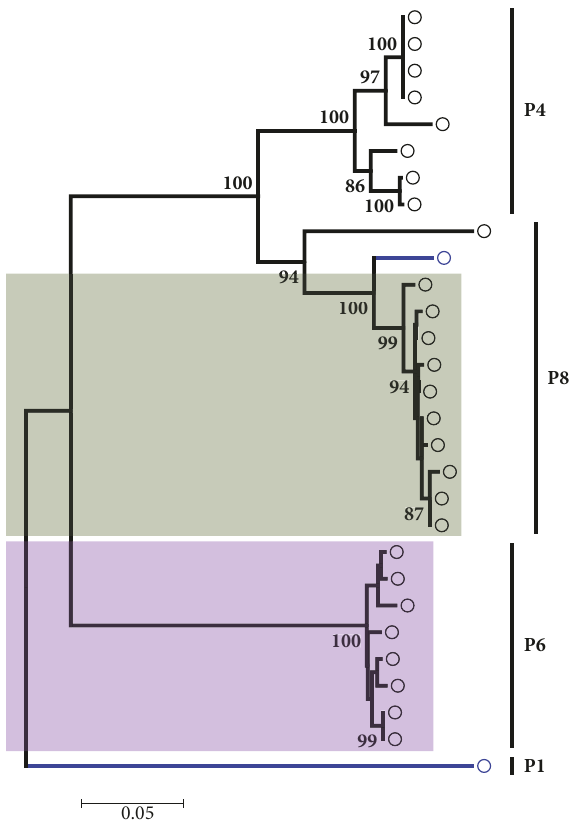
Figure 3: Phylogenetic analysis of the partial VP4 (P) gene sequences of Nigerian rotavirus strains from 1994 to 2015. Clinical isolates submitted to Genbank before the year 2000 are shown in blue. Genotype assignments are indicated by the side of the horizontal bars in the tree. The light grey shaded region shows isolates belonging to lineage III genotype P [8] , while the light purple shaded region shows isolates belonging to lineage I genotype P [6] . The phylogenetic tree was constructed using neighbor joining algorithm in MEGA 6.0 with 1000bootstrapreplicates. Thescale bar indicates number of substitutions per